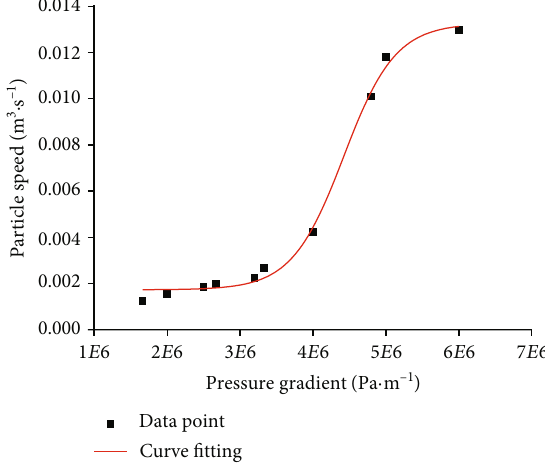
Figure 13: The relationship between pressure gradient and the particle